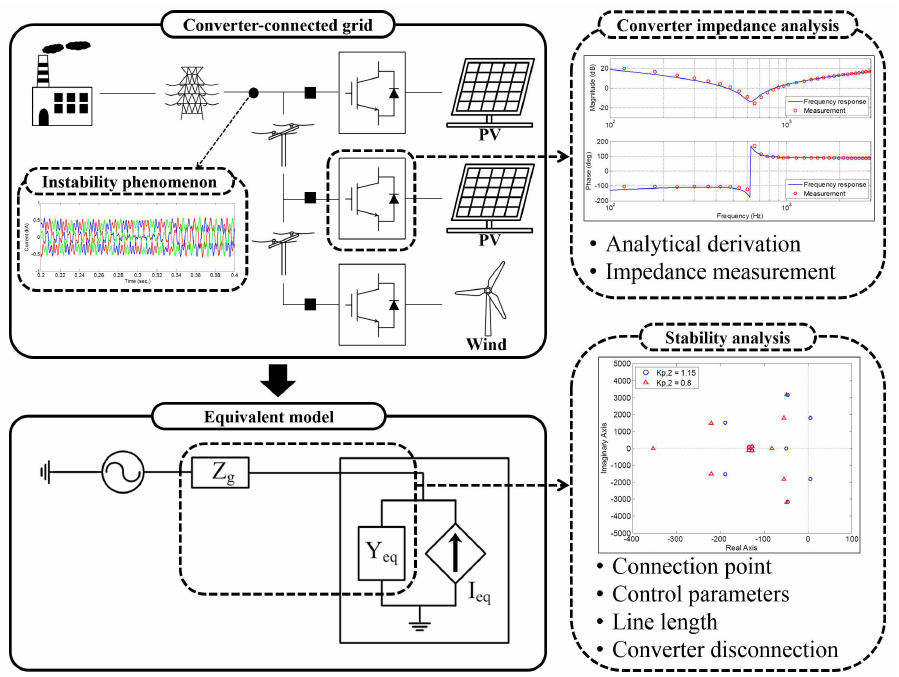
Figure 1. Proposed analytical approach: derive and validate the theoretical impedance models of a new converter-interfaced generator (CIG) and the power grid at the point of common coupling (PCC); conduct stability assessment for various planning options and operating